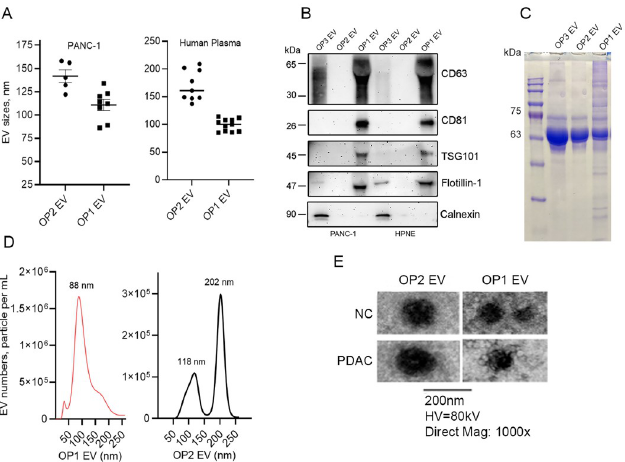
Fig 2. Characterization of EVs by nanoparticle tracking analysis, exosome marker detection, and electron microscopic examination. A . Nanoparticle tracking analysis of OP1and OP2 EVs derived from PANC-1 cells and healthy donor human plasma. B . Western blot analysis of CD63, CD81, TSG101, flotillin-1, and calnexin in the OP1, OP2, and OP3 EVs derived from PANC-1 cells (40 μ g protein each lane, non-reducing condition for CD63, n = 3). C . Coomassie blue staining of the SDS-PAGE gel loaded with proteins from OP1, OP2 and OP3 EVs (25 μ g each lane). D . Representative nanoparticle tracking analysis of OP1 and OP2 EV concentrations (PANC-1). E . Representative electronic microscopic images of OP1 and OP2 EVs (Human